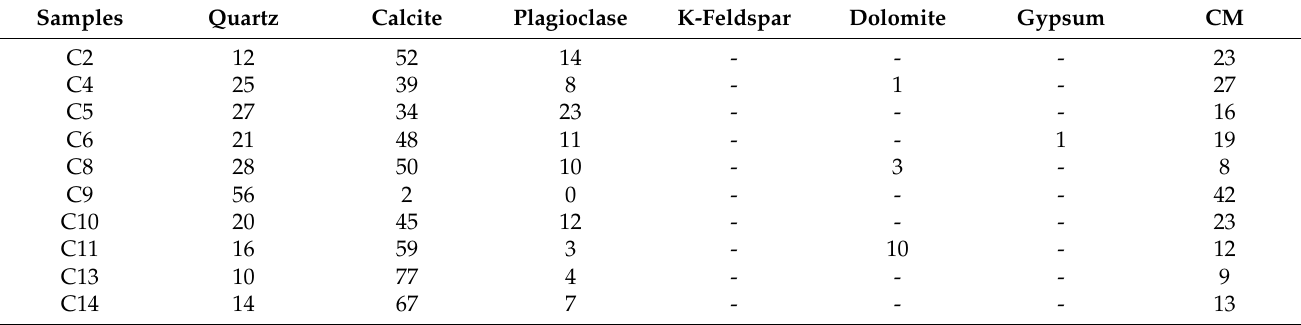
Table A4. Mineralogical composition of the whole sediment of EA, C, and X clayey raw materials (relative abundance %). Abbreviations: CM = total clay